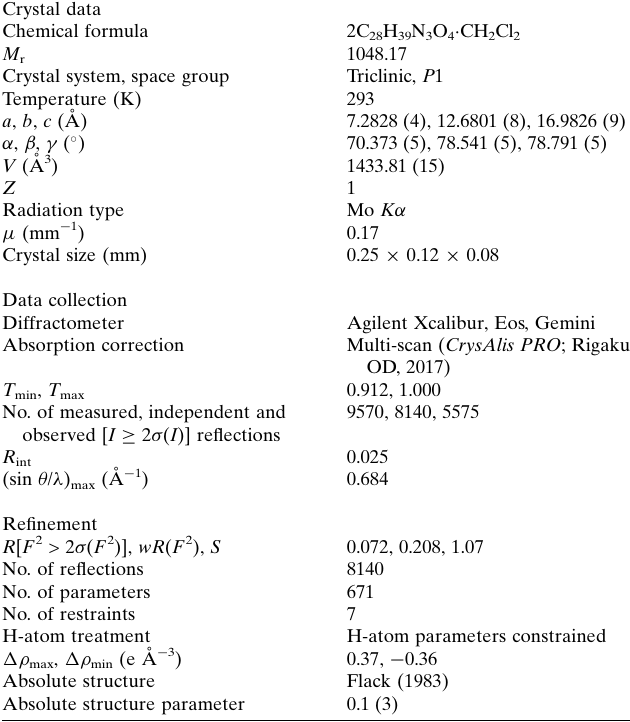
Table 2 Experimental details.